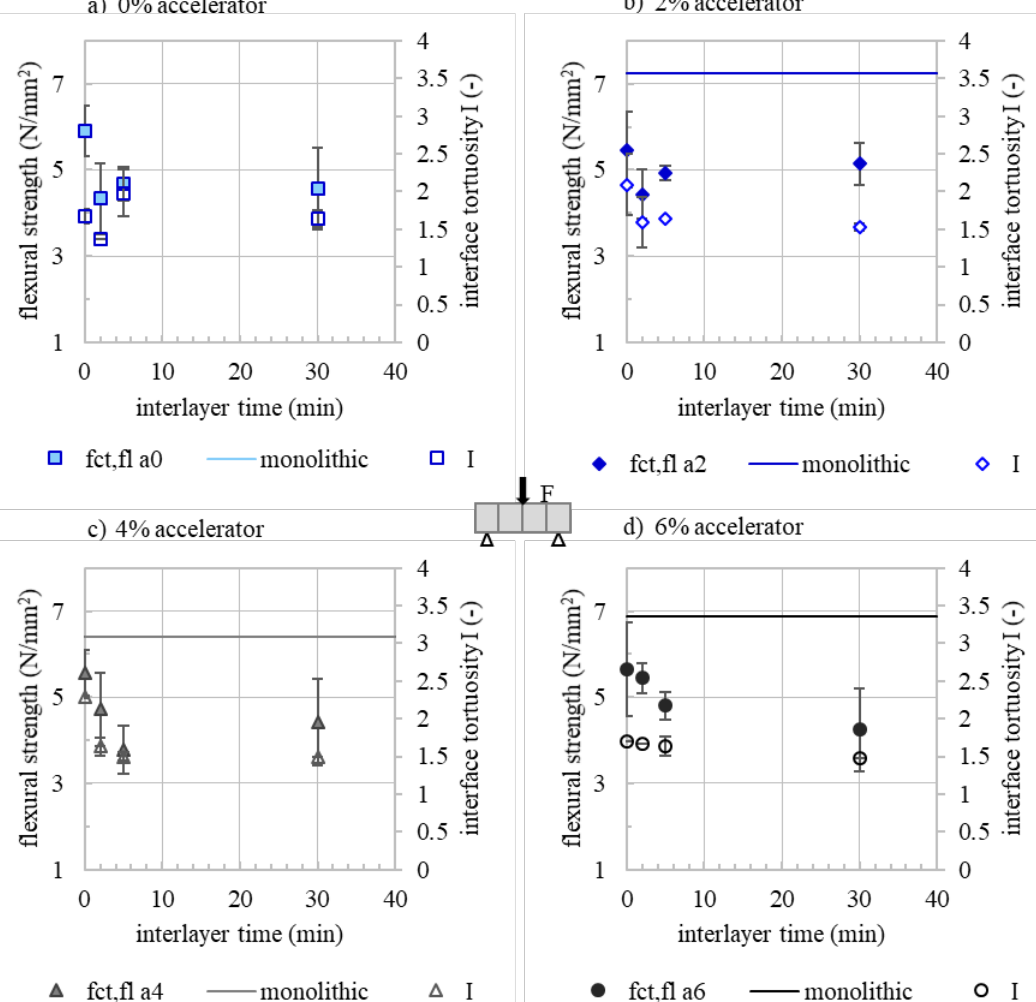
Figure 8. 28 d flexural strength f ct of monolithic specimen and specimen with various interlayer times as well as according interface tortuosity I of ( a ) a 0%, ( b ) a 2%, ( c ) a 4% and ( d ) a 6% (for each accelerator dosage, a minimum of six drilling cores and seven prisms is evaluated) depending on the interlayer time.